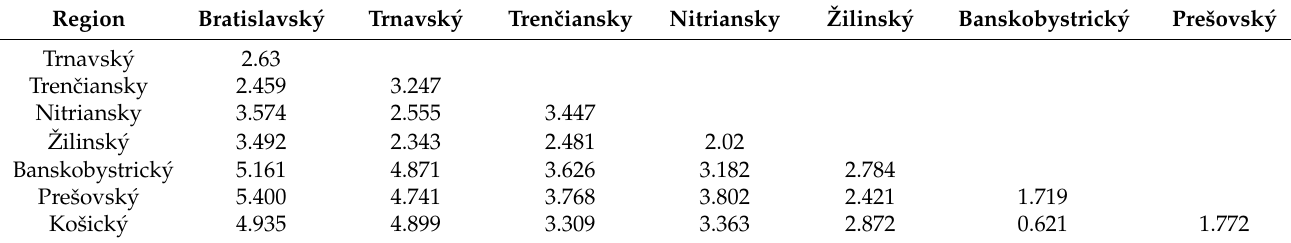
Table 12. Euclidean distance of regions in cluster analysis 2018.